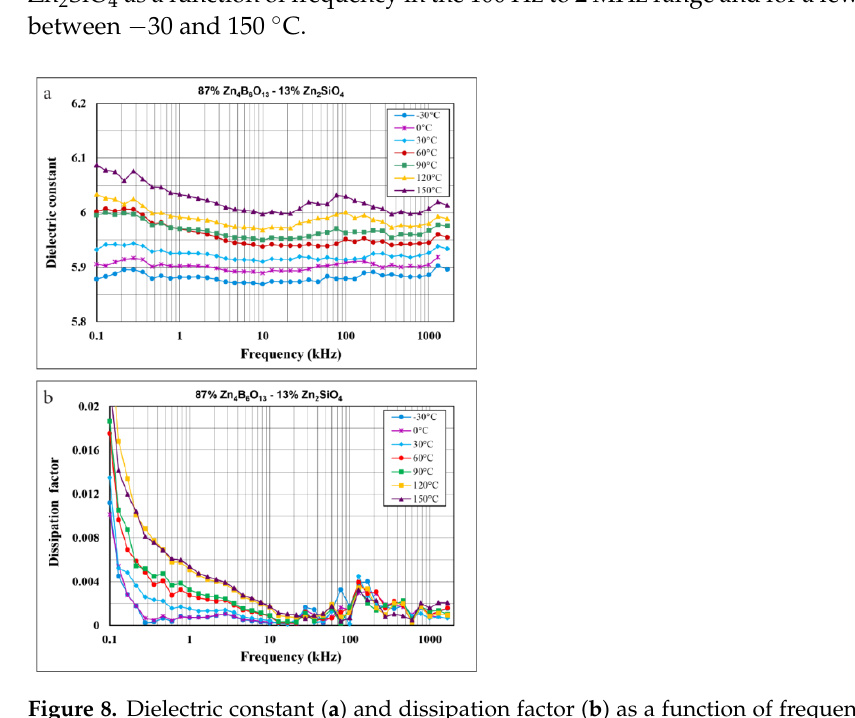
Figure 9. Comparison of dielectric constant at 20 °C as a function of frequency in the range 0.12–3 THz for Zn 4 B 6 O 13 , Zn 2 SiO 4 , and Zn 4 B 6 O13–Zn 2 SiO 4 ceramics.